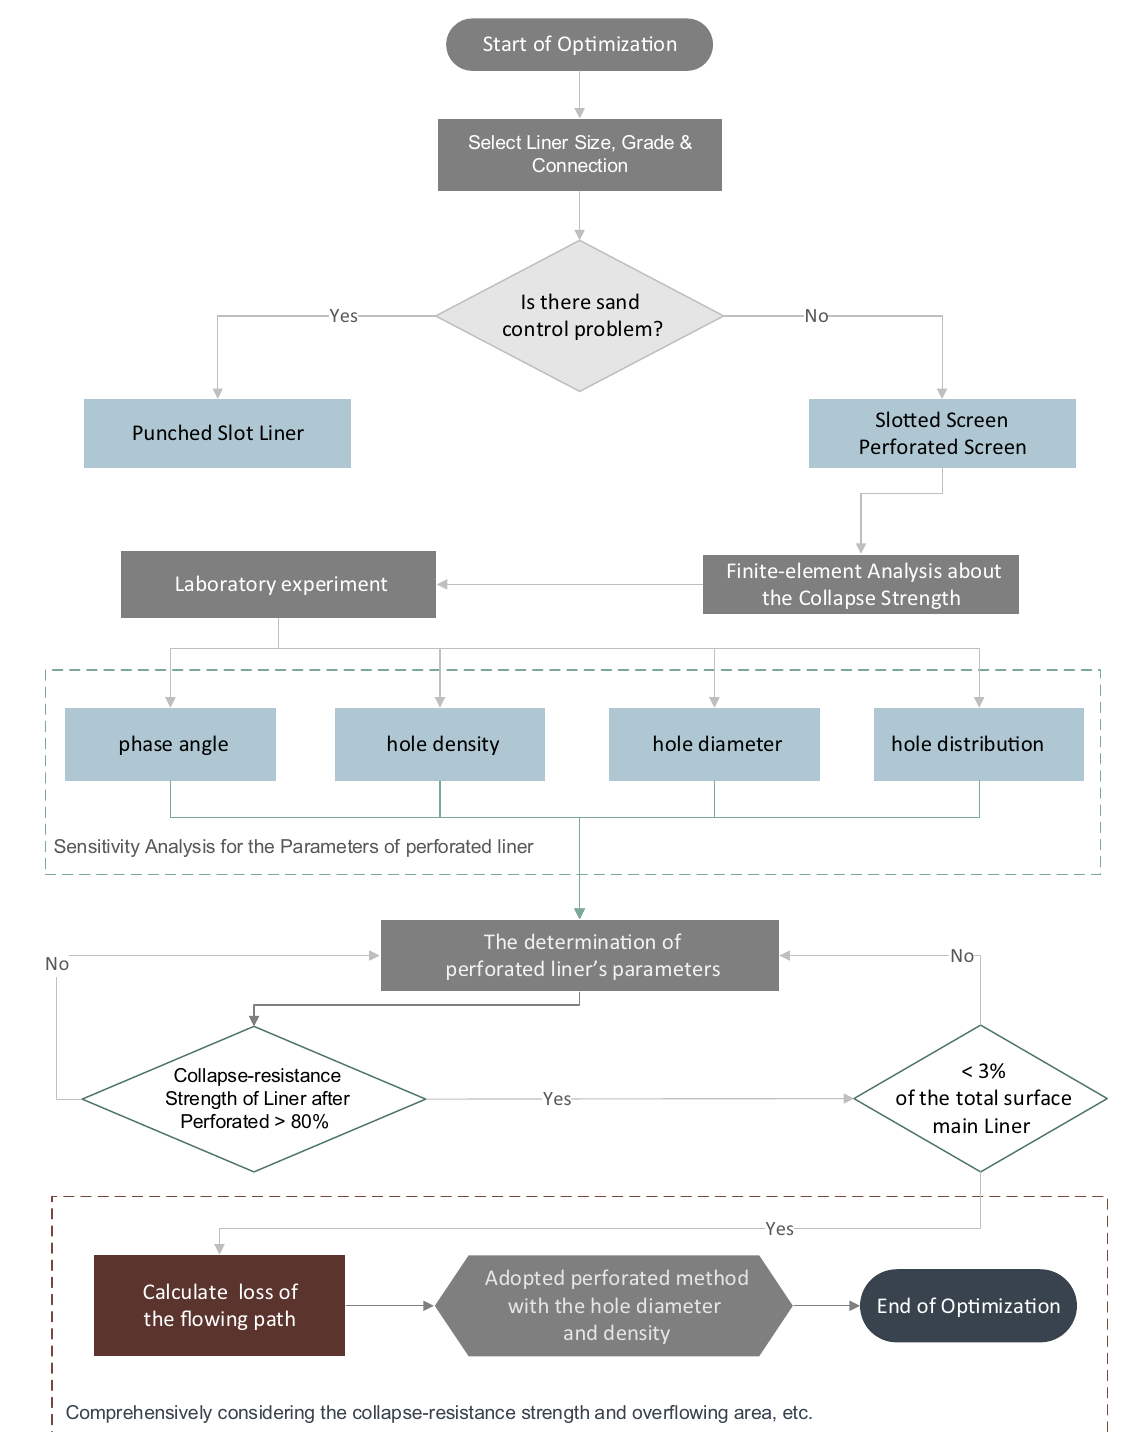
Fig. 1 Flowchart for screen liner